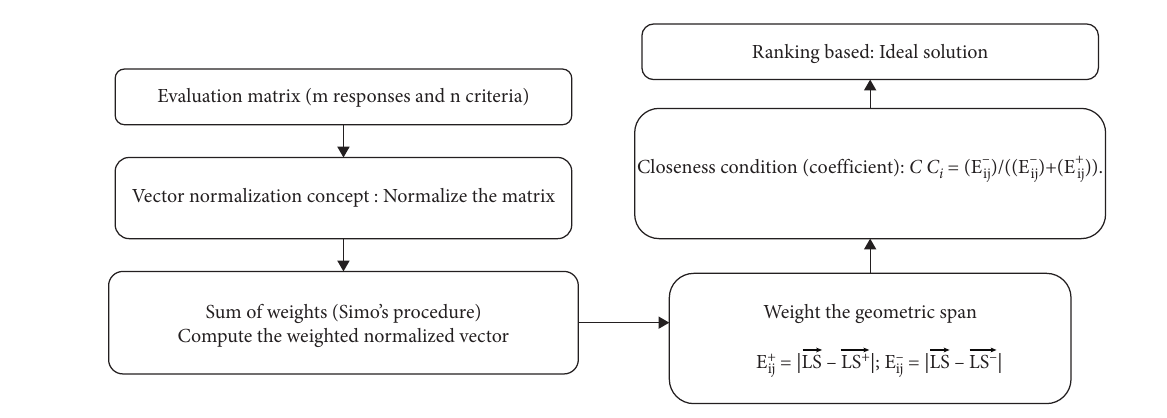
Figure 11: Methodology of TOPSIS (close to ideal solution).